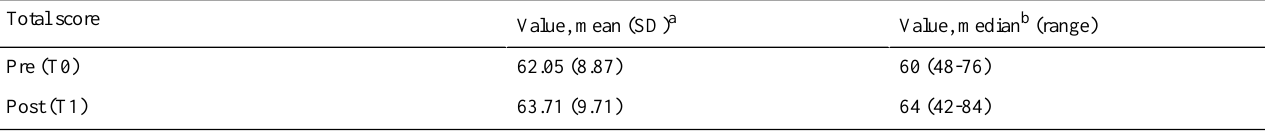
Table 3. Descriptive analysis of total pre- or